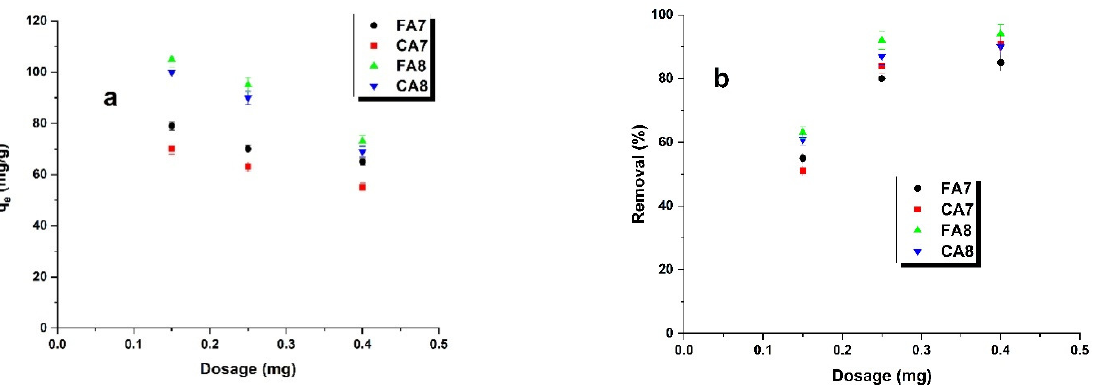
Figure 10. Effect of dosage ( a ) and adsorption efficiency ( b ) on the adsorption of methyl red sodium salt on biocarbons.